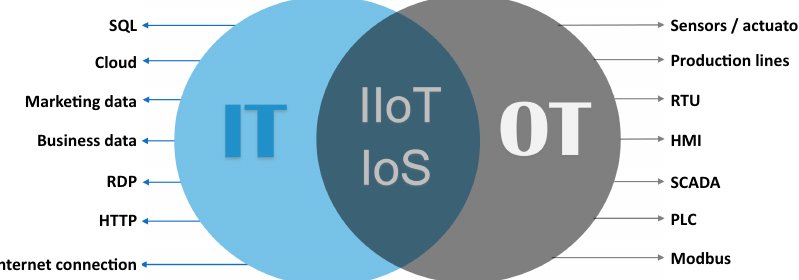
Figure 1. IT and OT